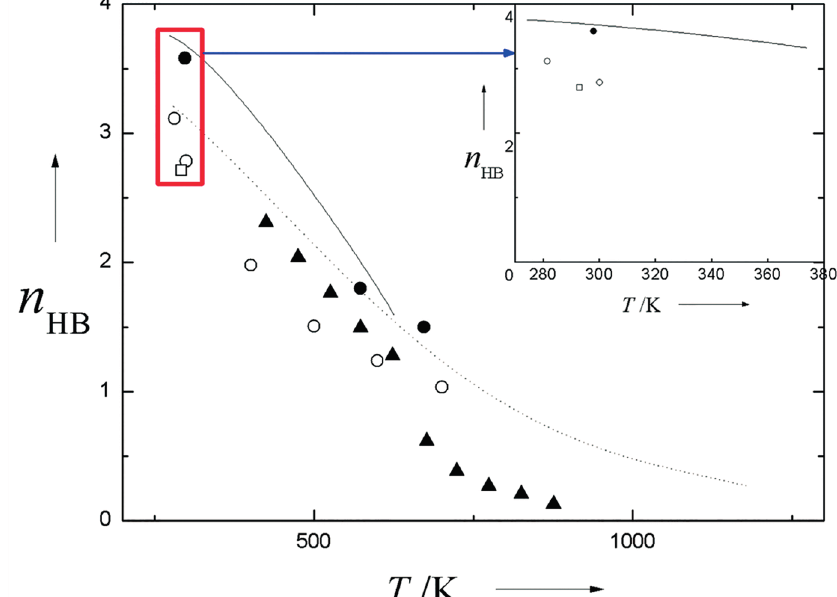
Figure 3. Comparison of n obtained from various molecular simulations and spectrum HB studies. Dot line: MC (TIP4P) simulations at 100 MPa [56], solid line: molecular simulations based on cluster theory [42], solid triangle: estimations from NMR shift at pressure ranging from 2.5 to 40 MPa [53], solid circle: estimations from neutron diffraction at 0.1, 9.5, 80 MPa, respectively [54], hollow circle: MD calculations based on fluctuating-charge TIP4P-FQ model [55], hollow square: estimations from Raman spectrum at ambient condition [13]. Four estimated n and one line are shown in the inset HB to give a better comparison for ambient water at 0.1